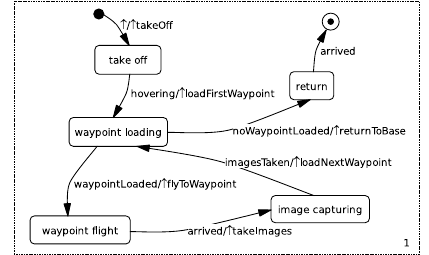
Figure 3: Example of an ESM state diagram defining a simple mission plan.